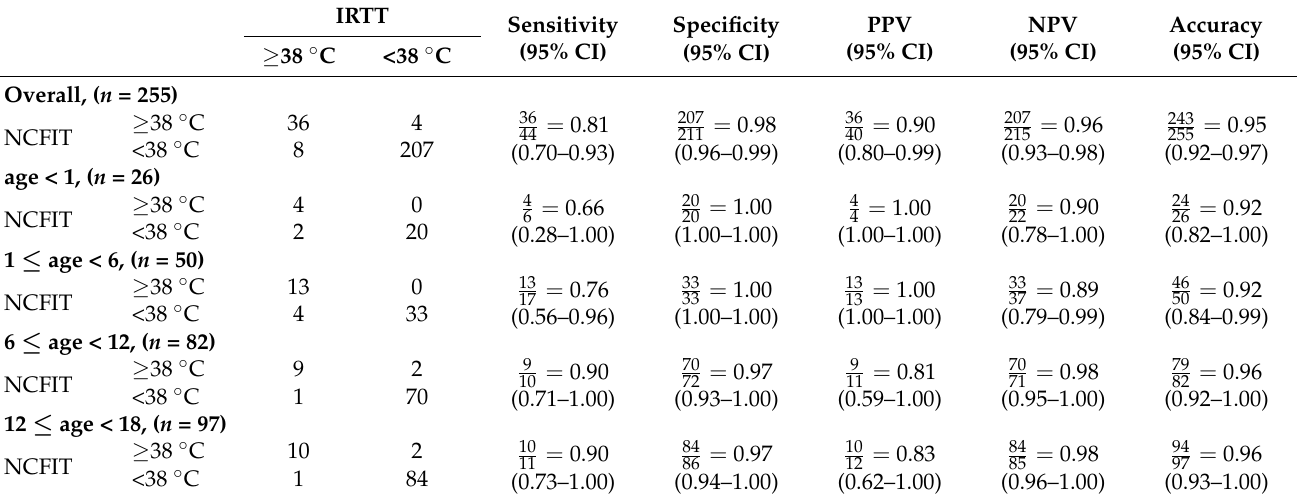
Figure 3. Agreement between NCFIT and IRTT using Bland–Altman plots. ( a ) Overall age, ( b ) <1 year of age, ( c ) 1–5 years of age, ( d ) 6–11 years of age, and ( e ) 12–18 years of age. Bland–Altman plots of difference indicate the mean temperature difference and 95% limits of agreement: comparison of the difference between each NCFIT and IRTT paired temperature measurement. The middle horizontal line represents the mean difference in these two measurements, and the other horizontal lines represent 2SDs above and below the mean difference. Table 3. Sensitivity, specificity, PPV, NPV, and accuracy about over 38 ◦ C between non-contact infrared and tympanic. temperatures in different age groups †